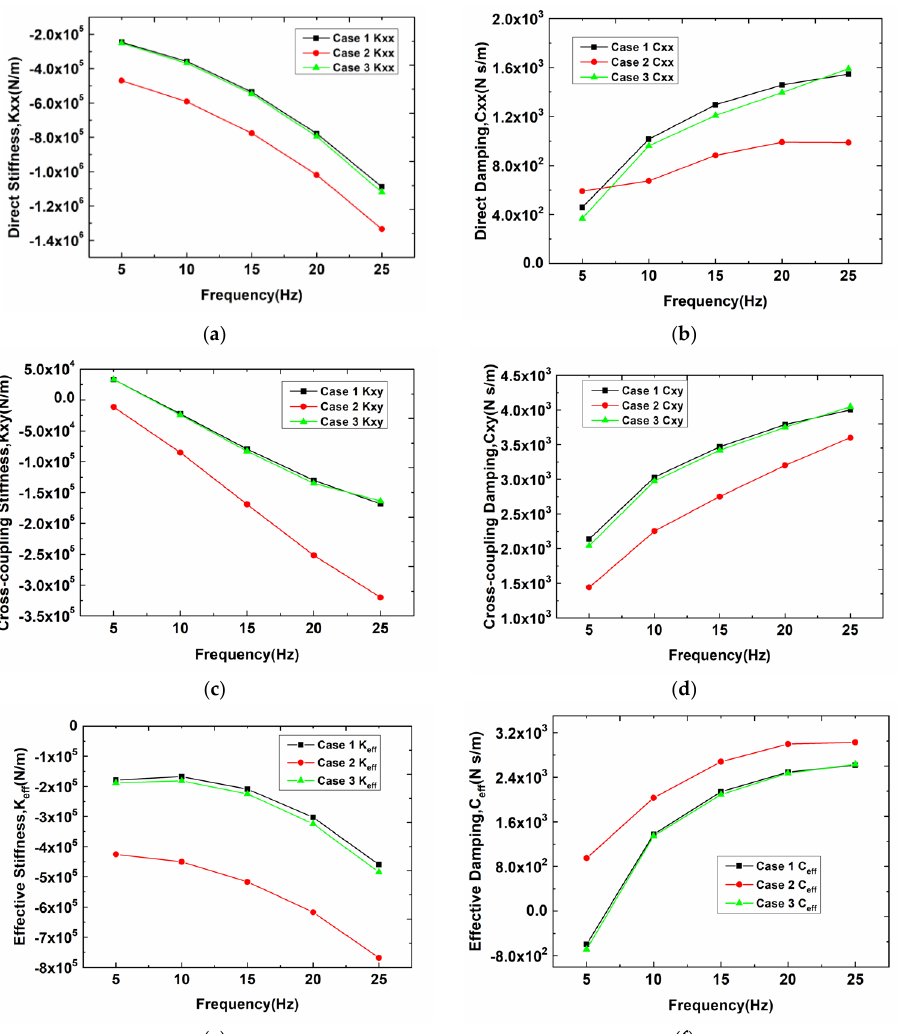
Figure 10. ( a ) Direct stiffness K xx , ( b ) direct damping C xx , ( c ) cross-coupling stiffness K xy , ( d ) cross- coupling damping C xy , ( e ) effective stiffness K eff and ( f ) effective damping C eff of the annular seal with impeller blades number m = 5.